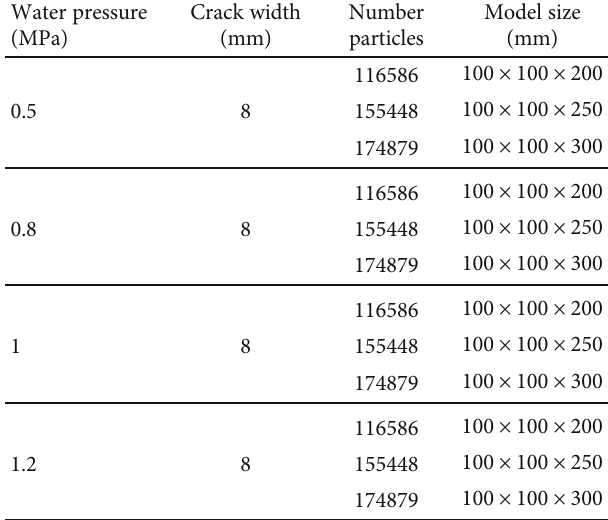
Table 2: Design of numerical